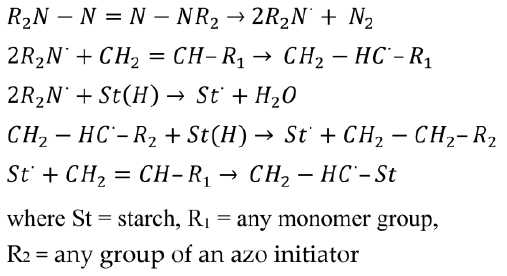
Figure 16. Asobisisobutryonitrile ( AIBN) initiation of vinyl monomer or starch. Adapted from [11].